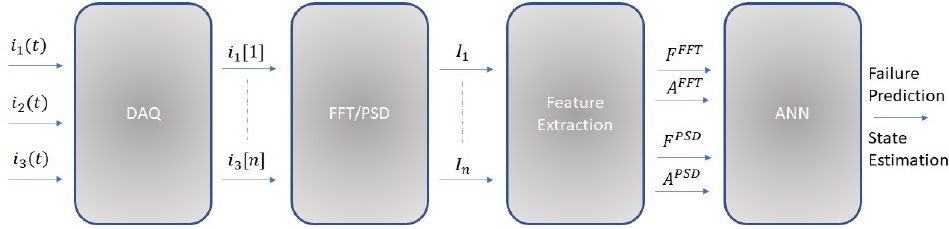
Figure 4. Block diagram of the proposed